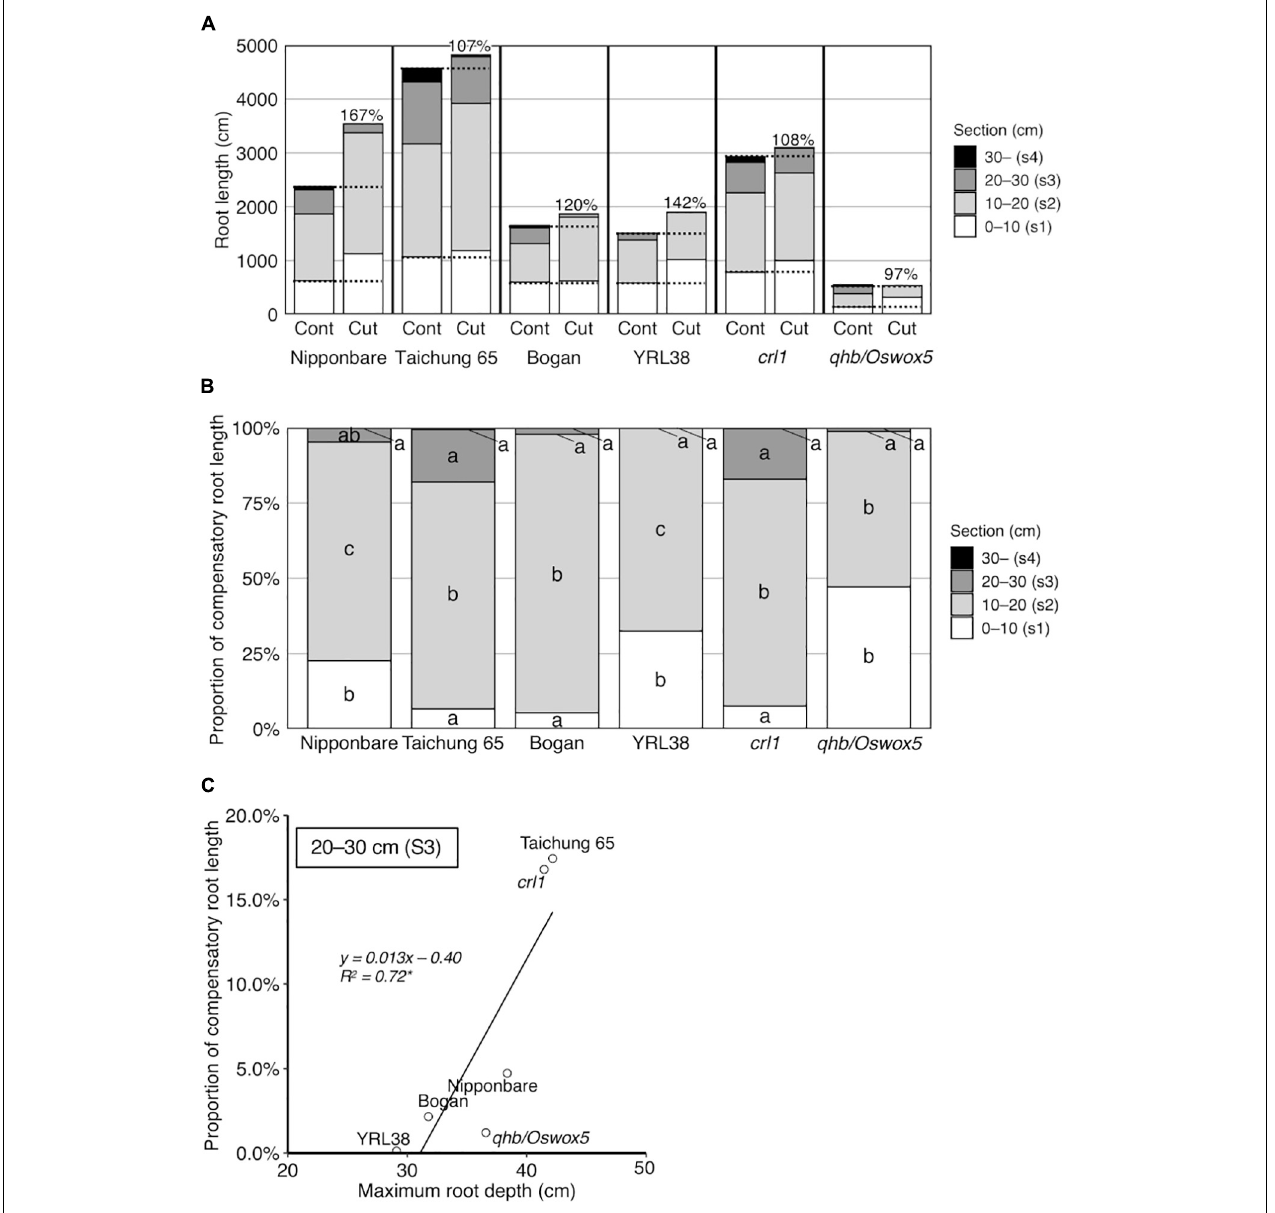
FIGURE 6 | Compensatory root growth in response to the root cutting treatment in six rice genotypes grown in a semihydroponic phenotyping platform for 41 days after transplanting. (A) RL in four sections. Percentages on bars indicate the compensation rate for each genotype. (B) Proportion of compensatory RL in four sections. Values represent means ( n = 3–6). Bar data with different letters indicate significant differences among sections in each genotype ( p < 0.05). (C) Correlations between MRD in the control and proportion of compensatory RL in section 3 (* p <